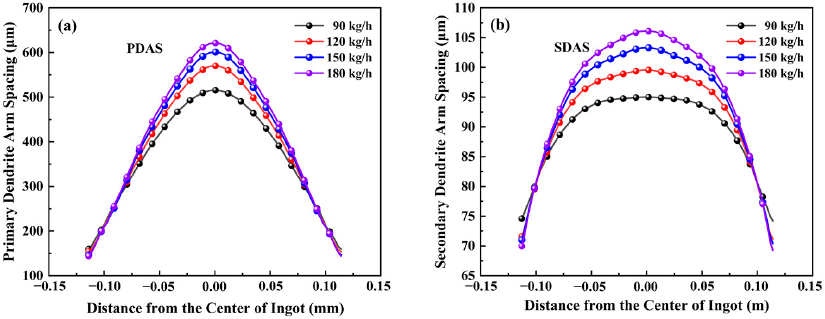
Figure 12. Change of PDAS ( a ) and SDAS ( b ) along radical direction with varying melting rate.